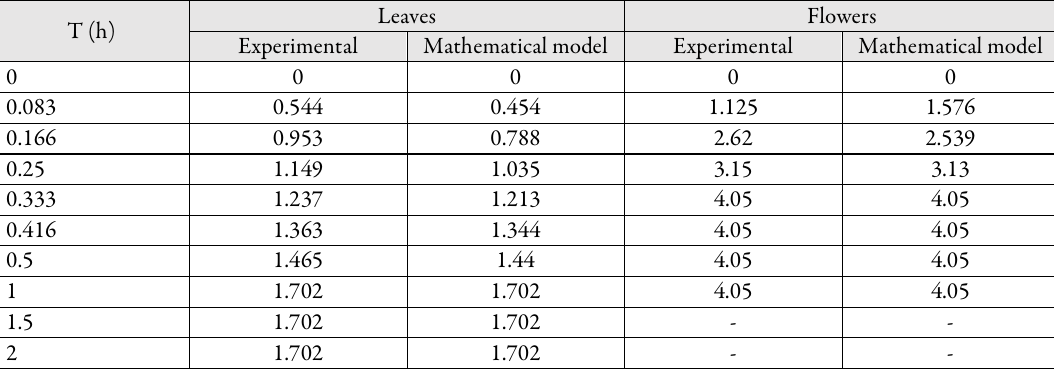
Table 1. The mathematical and experimental data of yield extraction according to the time